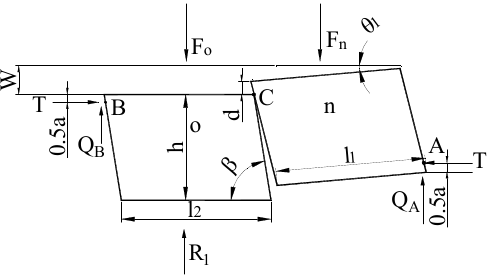
Figure 2. Structural mechanics model of inclined step-cuting body. Where F o and F n represent the sum of self-weight and load of block o and